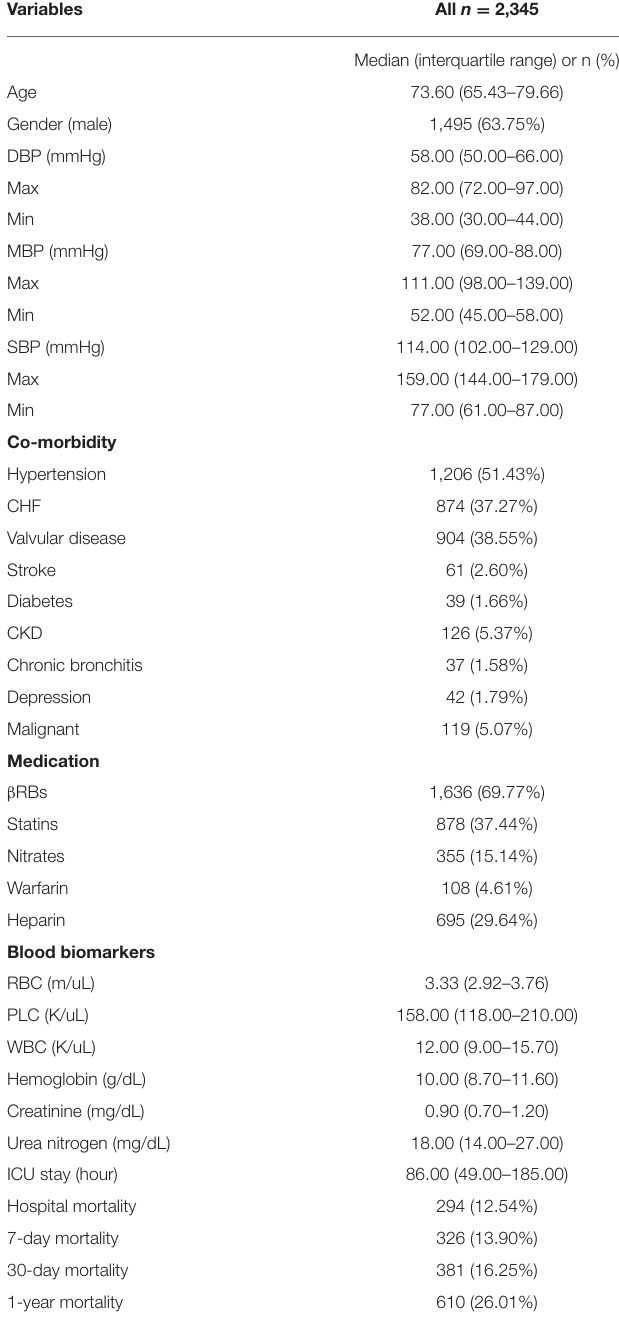
TABLE 1 | Clinical characteristics of ICU patients with